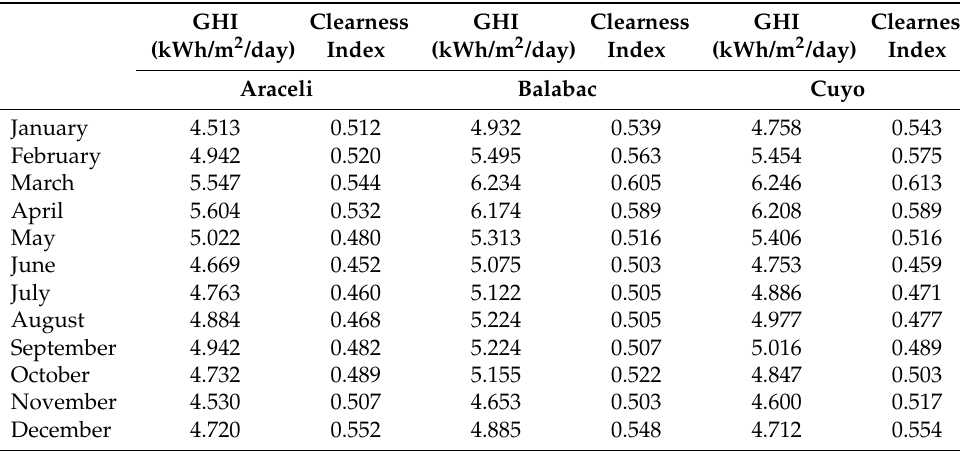
Table 2. Monthly average solar GHI and clearness index.